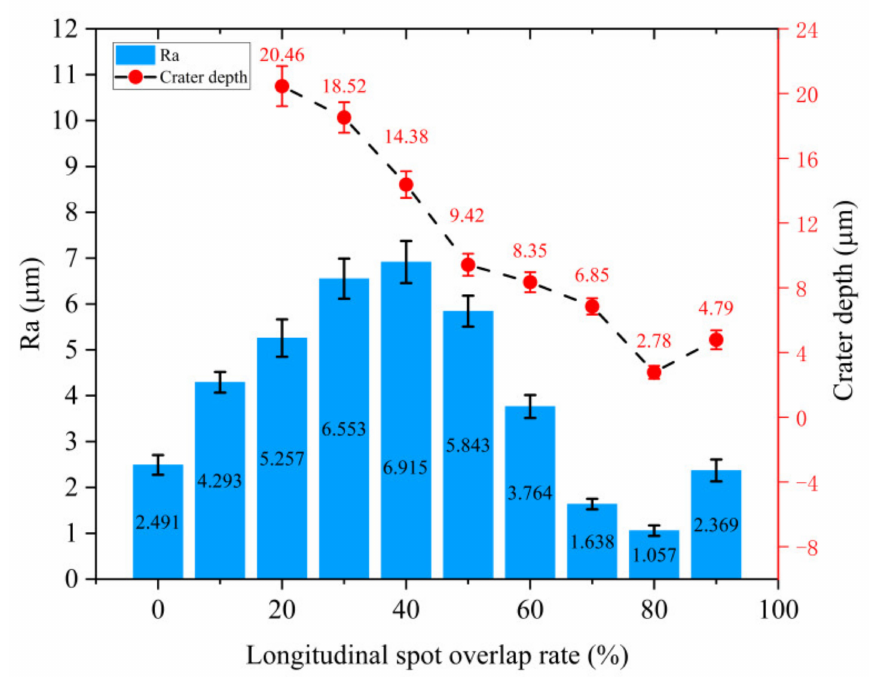
Figure 11. Effect of longitudinal spot overlap rate of the water jet-guided laser on surface roughness of samples.